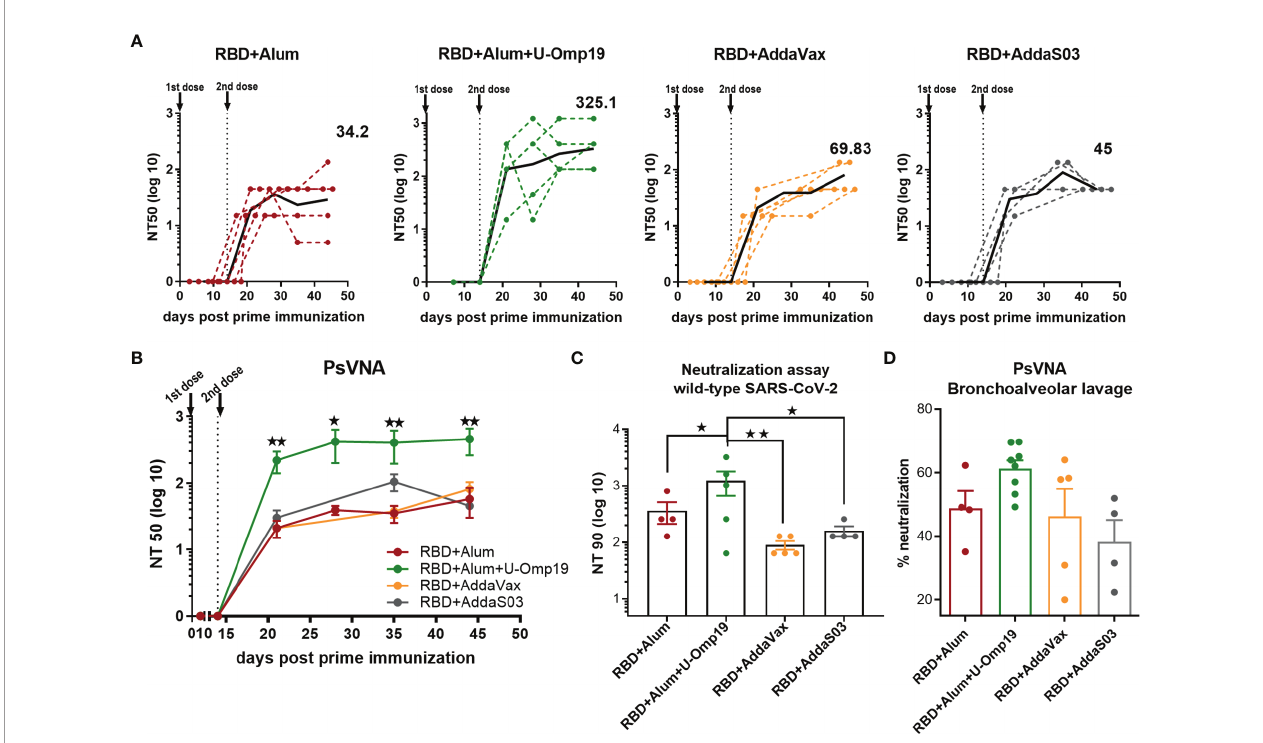
FIGURE 3 | Immunization with RBD+Alum+U-Omp19 increases systemic and mucosal neutralizing antibody titers. (A) BALB/c mice were vaccinated as described in Figure 2 . Serum neutralizing-antibody titers determined by pseudo-typed SARS-CoV-2 assay for each group of vaccinated mice at different time points. The black lines represent the geometric mean of all data points, and numbers are GMT on day 44. Dotted lines represent the mean titer of each mouse at indicated time points. Titers correspond to the 50% of virus neutralization (NT50). (B) Kinetics of neutralizing antibody titers of all groups determined by pseudo-typed SARS-CoV-2 assay. Points are means ± SEM. Titers correspond to the 50% of virus neutralization (NT50). *p < 0.05. **p < 0.01. One-way ANOVA with Bonferroni post-test. (C) Neutralizing antibody titers against ancestral SARS-CoV-2 virus at day 44 post prime immunization. Neutralization titer was de fi ned as the highest serum dilution without any cytopathic effect in replicable wells (NT 90). Data are shown as means ± SEM. *p < 0.05. **p < 0.01. One way ANOVA with Bonferroni post-test. (D) BALB/c mice were vaccinated at day 0 and day 14 via i.m. with RBD+Alum (n = 4), RBD+Alum+U-Omp19 (n = 8), RBD+AddaVax (n = 5), or RBD+AddaS03 (n = 4). Determination of neutralizing antibodies in the bronchoalveolar lavage by pseudo-typed SARS-CoV-2 assay at day 44. Data are expressed in percentage of neutralization compared with controls (virus alone). Results are representative of two independent